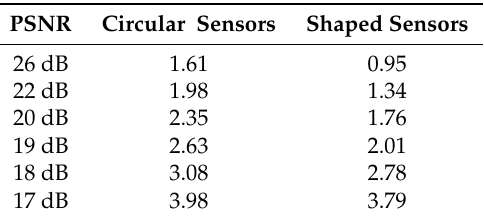
Table 1. Comparison of Standard Deviation (SD) for the conventional cluster and proposed cluster of shaped sensors for noise-affected measurements at different Peak Signal to Noise Ratio (PSNR) values (SD Values are in [Deg]).